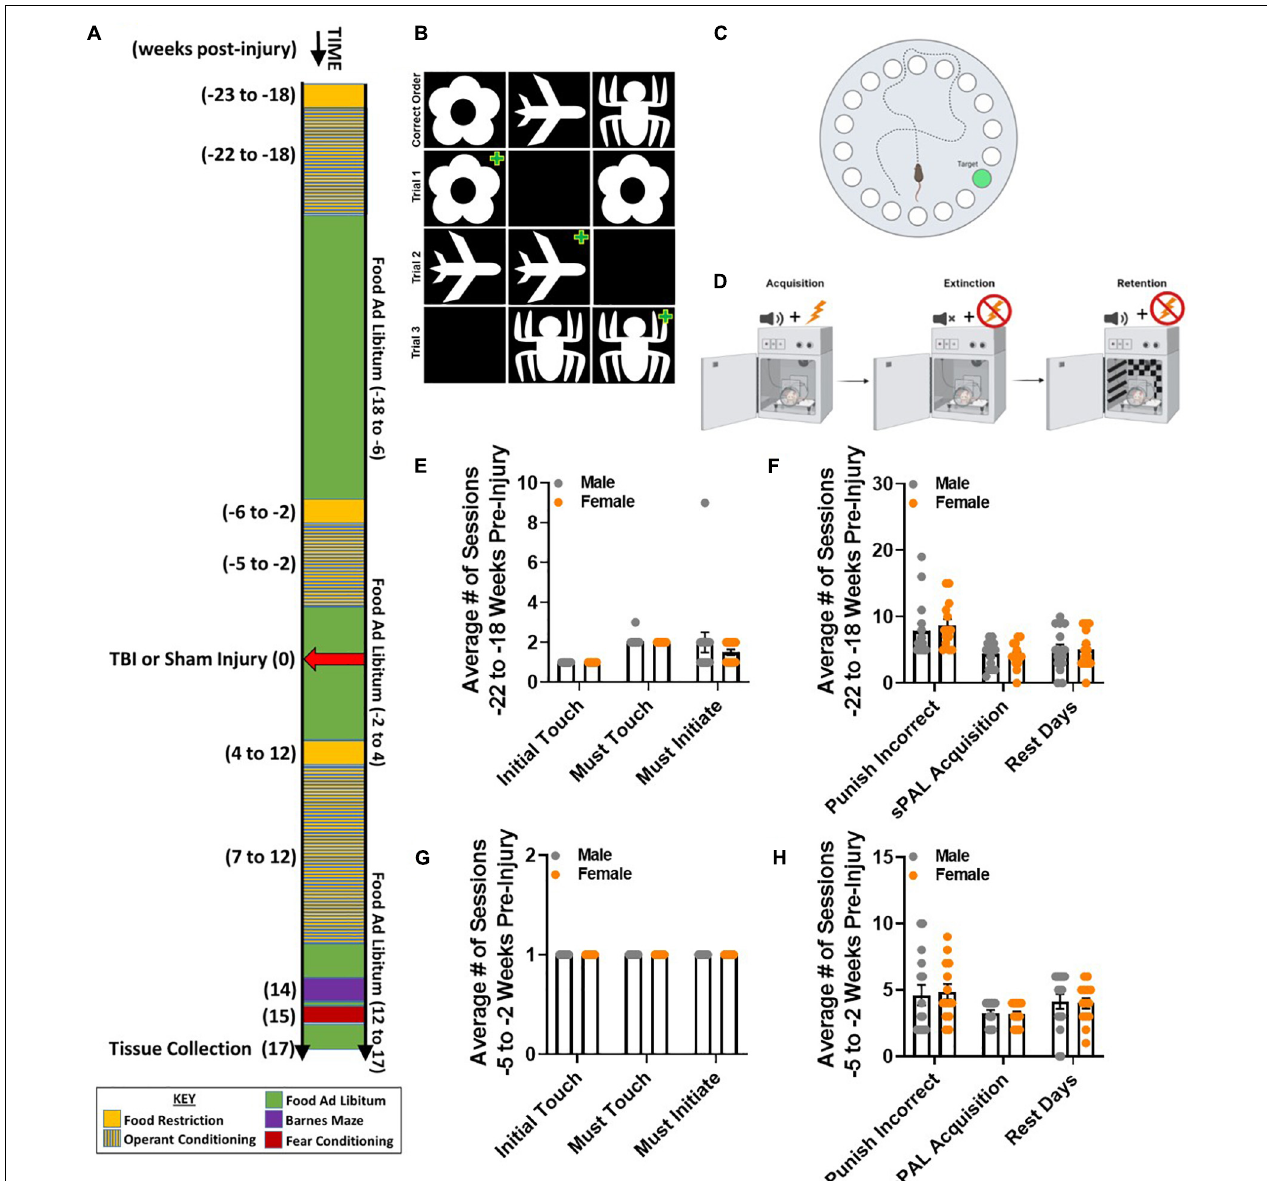
FIGURE 1 | Acquisition of paired associate learning (PAL) is similar between naïve male and female mice. (A) Experimental timeline spanning approximately 40 weeks, including both pre- and post-injury behavioral testing to evaluate retrograde and anterograde memory, respectively. (B) Cartoon of the PAL task, displaying the correct order of images: flower, plane, and spider. Three example trials in which two of the same image are shown. To make a correct choice, a mouse must touch the image that is in the correct location. A green plus symbols identifies the correct choice. (C) Cartoon aerial view of the Barnes maze. Extra-maze cues are placed around the elevated maze to facilitate measurement of spatial reference memory across 5 testing days. Latency to locate the hole with a goal box is the primary dependent variable of interest. Shorter latency across testing days indicates improved performance. (D) Cartoon of conditioning equipment to measure fear memory. During acquisition, a mouse is exposed to multiple tone-shock pairings. During extinction, a mouse is exposed to the same testing environment as acquisition with no tone-shock pairings. During retention, a mouse is placed in a novel environment with the same tone-shock pairing as during the acquisition phase. Time freezing is the primary dependent variable of interest. (E–H) Male and female mice did not differ in number of sessions for Initial Touch, Must Touch, Must Initiate, Punish Incorrect, or PAL Acquisition -22 to -18 weeks pre-injury or -5 to -2 weeks pre-injury. Rest days were similar across sexes and at both time points. N = 7–8/group; error bars indicate SEM. Panels (C,D) made with